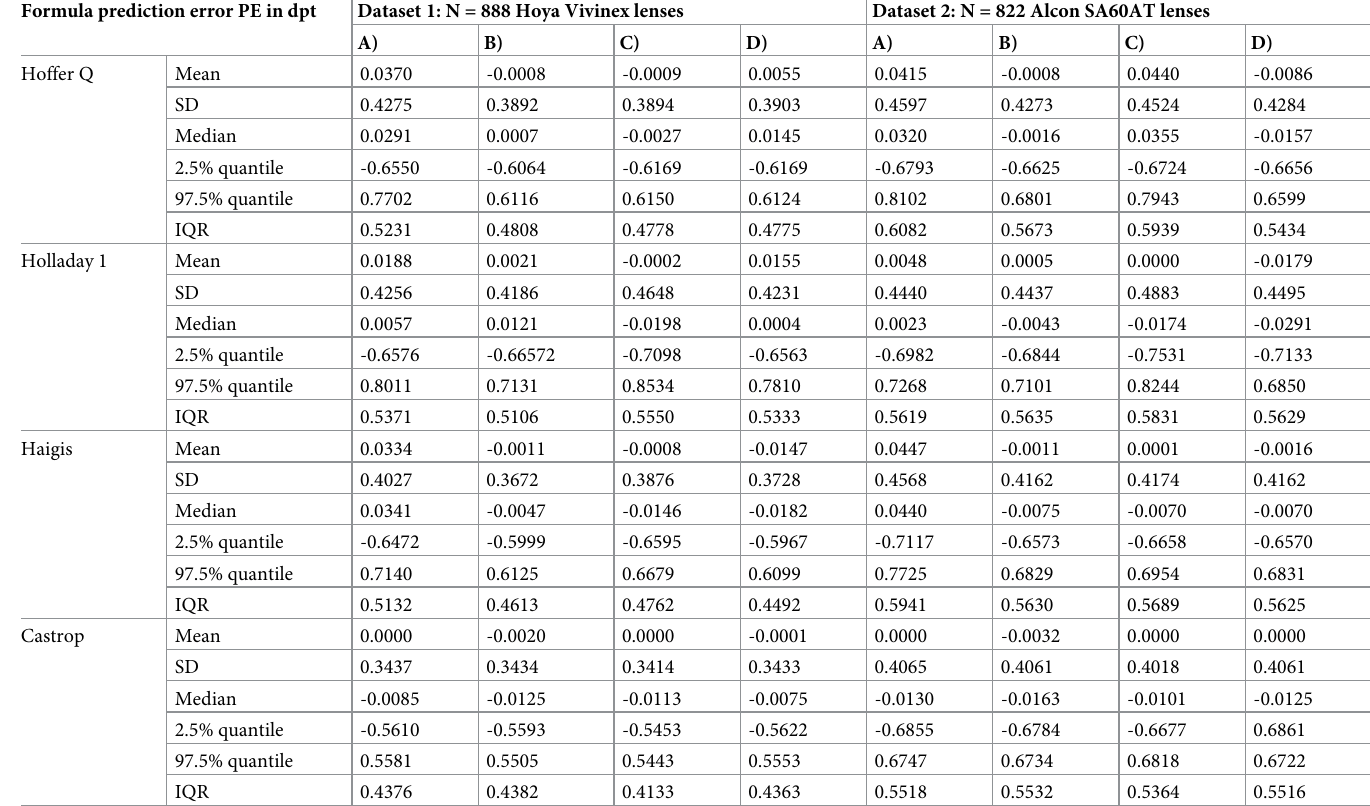
Table 3. Formula prediction error PE (difference of the SEQ measured after cataract surgery minus the formula predicted SEQ) for the Hoffer Q (pACD), the Hol- laday 1 (SF), Haigis (a0/a1/a2), and Castrop formula (C / H / R). SD refers to the standard deviation, 2.5% quantile and 97.5% quantile to the lower and upper boundary of the 95% confidence interval, and IQR to the interquartile range as the difference between the 75% and the 25% quantile. Formula constant optimisation was performed to minimise the sum of squared prediction errors PE. Situation A) refers to the ‘classical’ formulae with standard nK/nC values, with situation B) the formula constants and nK/nC in the main part of the formula were varied for optimisation, with situation C) the formula constants and nK/nC in the main part of the formula were varied to minimise for PE and the PE trend error over corneal radius, and with situation D) a standard optimisation was performed using the nK/nC value from situation B) derived from the other dataset in terms of a